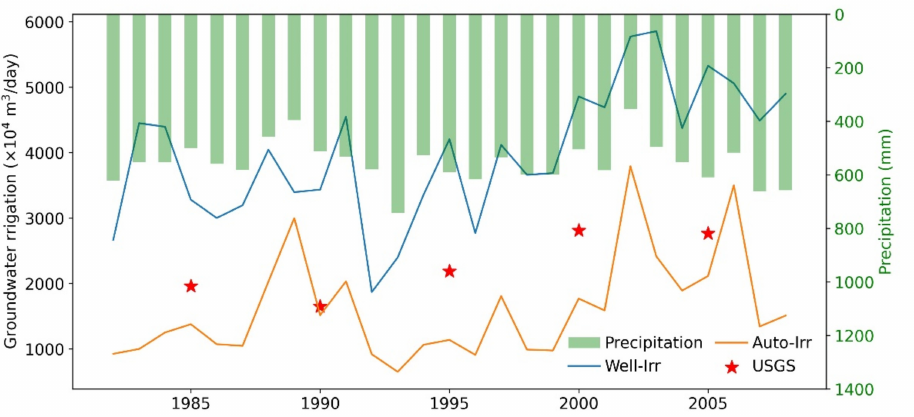
Figure 3. Reported and simulated total annual groundwater irrigation volume in the U.S. Northern High Plains